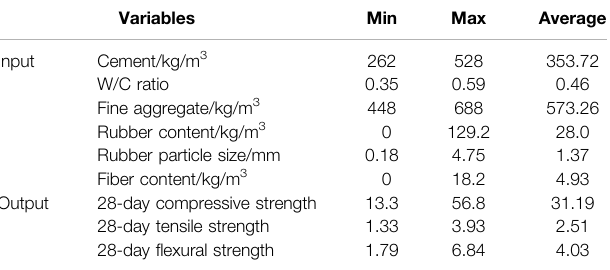
TABLE 9 | Input and output variable in the data